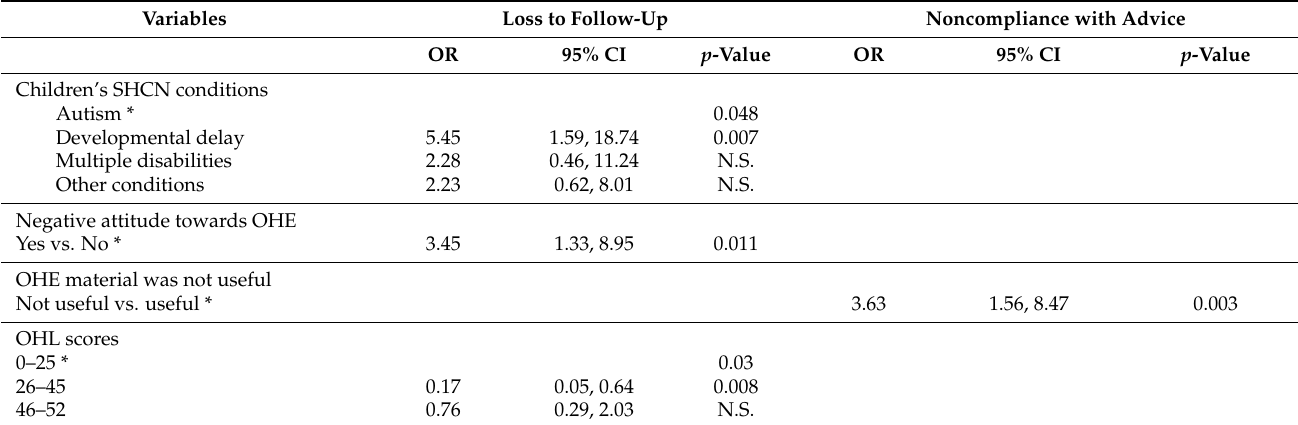
Table 3. Factors associated with parental compliance during the 24-month follow-up period (final model of binary logistic